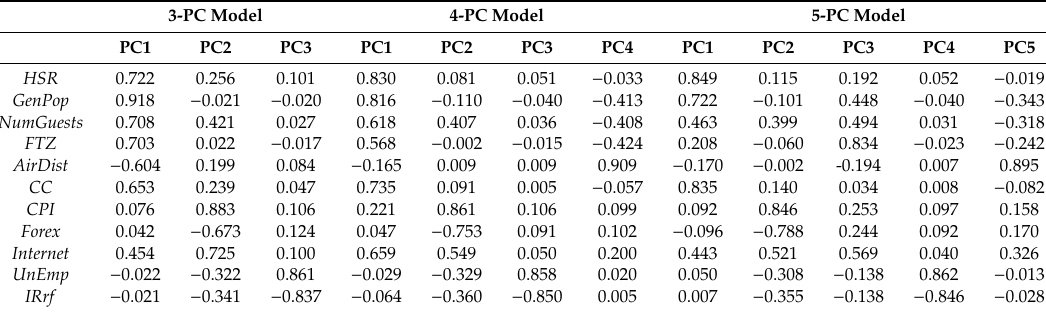
Table 4. Variable loadings for 3, 4, and 5 principal component (PC)